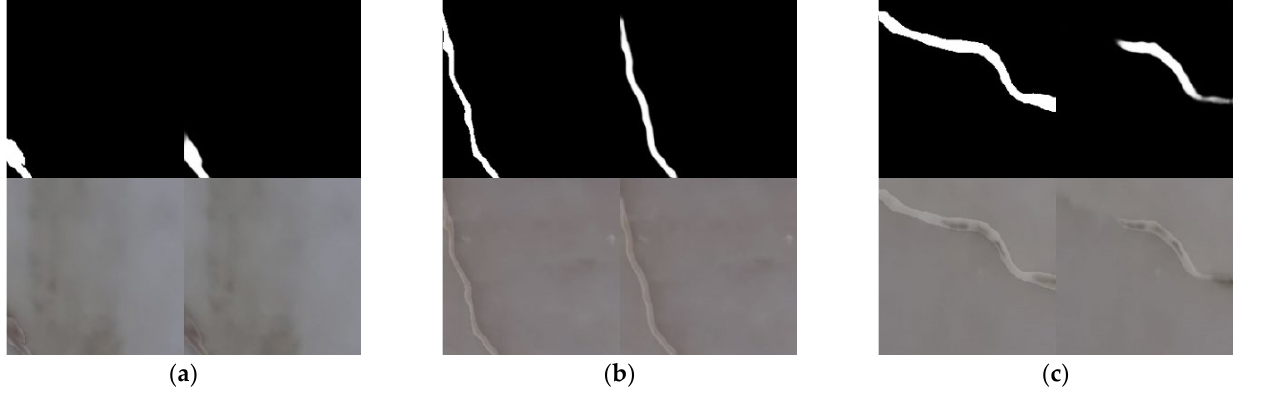
Figure 7. Indicative images of the testing set to illustrate FPN performance. For each image: up–left is the ground truth image, down–left is the RGB input image, up–right is the output segmentation and down–right is the output segmentation mask applied to the input image. ( a ) Best (IoU 98.46% with seresnet152); ( b ) medium (IoU 93.24 with seresnet50); ( c ) moderate (IoU 37.41 with seresnet50).